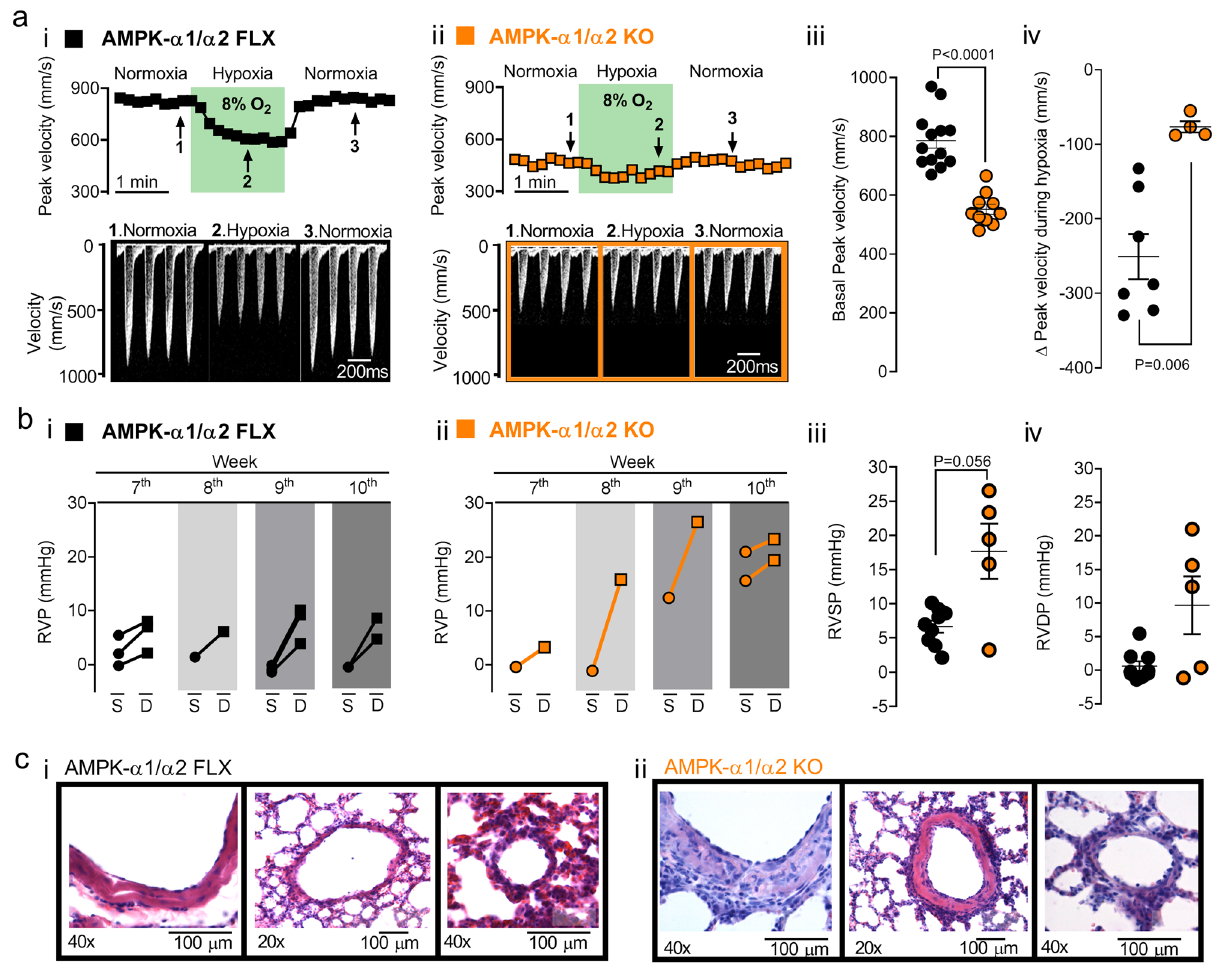
Fig. 6 | AMPK- α 1/ α 2 deletion increased pulmonary vascular resistance and attenuated hypoxic pulmonary vasoconstriction after birth. a i-ii Upper panels showrepresentativespectralDopplerpeaksystolicvelocitiesversustimewithinthe mainpulmonaryarteryof(i)AMPK- α 1/ α 2 fl oxed(FLX)and(ii)AMPK- α 1/ α 2KOmice during normoxia, hypoxia (8% O 2 ) and recovery; lower panels show example records of Doppler velocity during normoxia, hypoxia (shaded green) and recov- ery. Scatter plots show the mean±SEM for the (iii) basal peak velocity under nor- moxiafor AMPK- α 1/ α 2 FLX( n =13mice) and AMPK- α 1/ α 2KO( n =10 mice)and (iv) the maximum change in peak velocityobserved during 8%O 2 for AMPK- α 1/ α 2 FLX ( n =7 mice) and AMPK- α 1/ α 2 KO mice ( n =4 mice). b Graphs illustrate age-